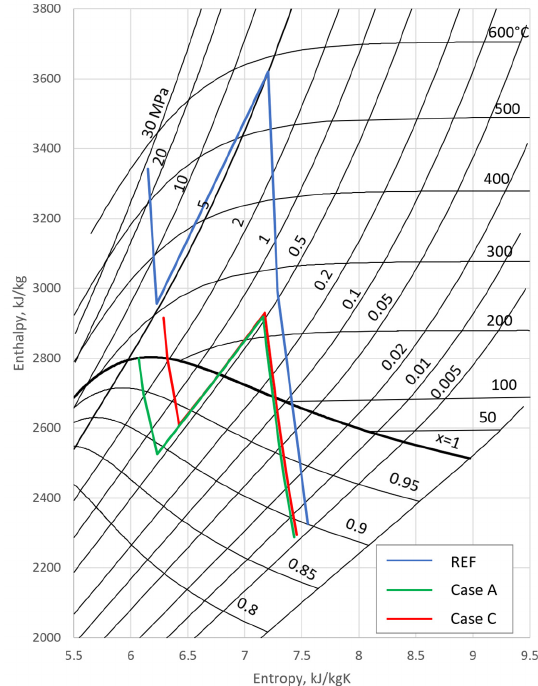
Figure 7. Steam expansion line in the turbine of the 460 MW power unit (REF) and post-modernization state (Casa A and Case C).